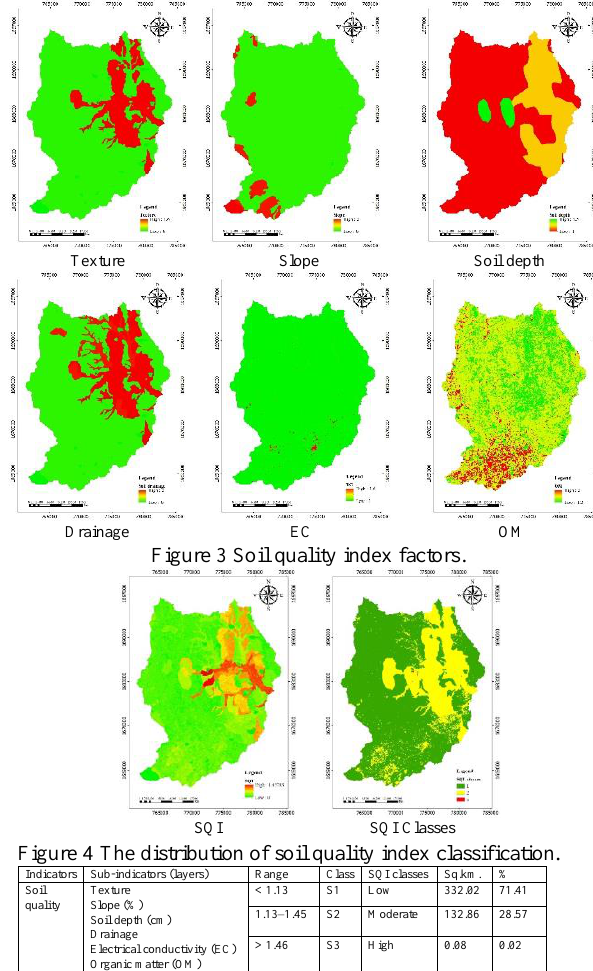
Table 5. Quantitative scores and qualitative classes